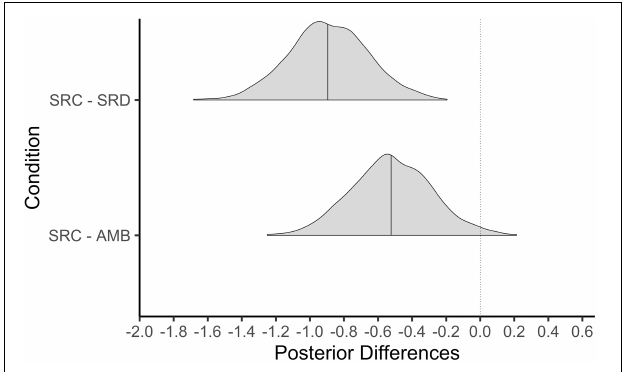
FIGURE 4 | Posterior differences in heart rate by condition. Solid line represents the 50th percentile and the dotted line is 0 = no difference. condition ( M = 2.7, SD = 0.8). Here, the posterior probability of a negative difference was